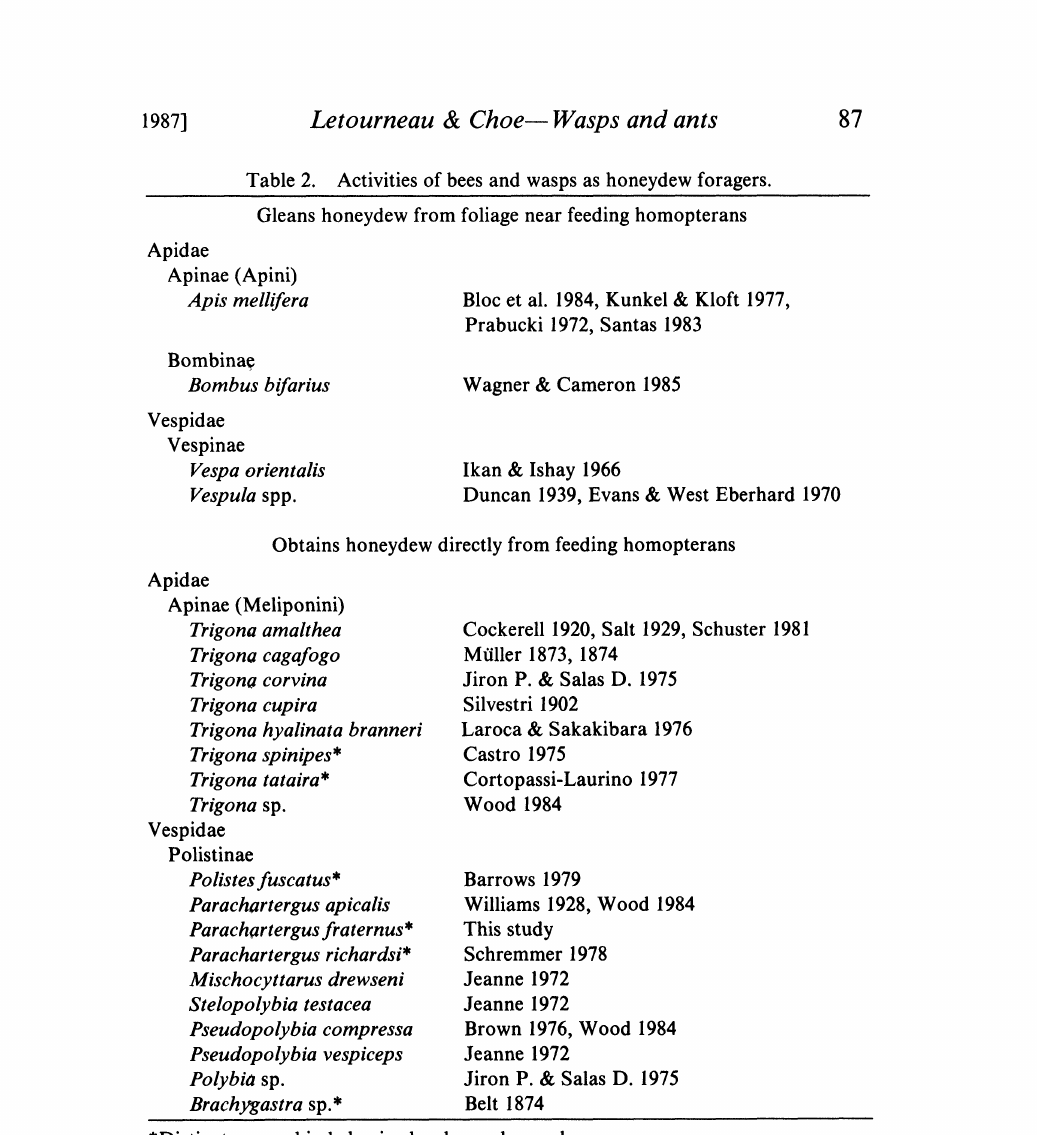
Table 2. Activities of bees and wasps as honeydew